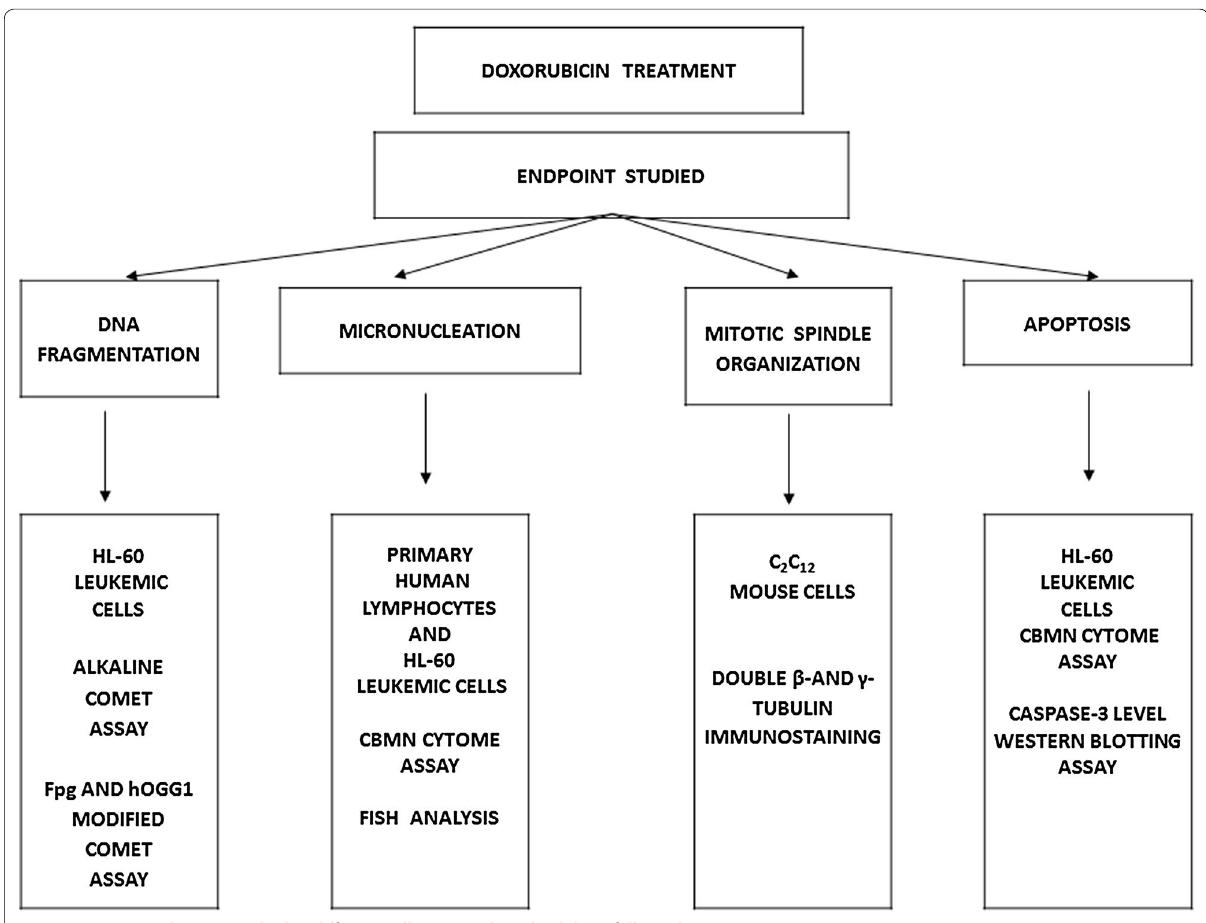
Fig. 1 Genetic endpoints studied in different cell types and methodology